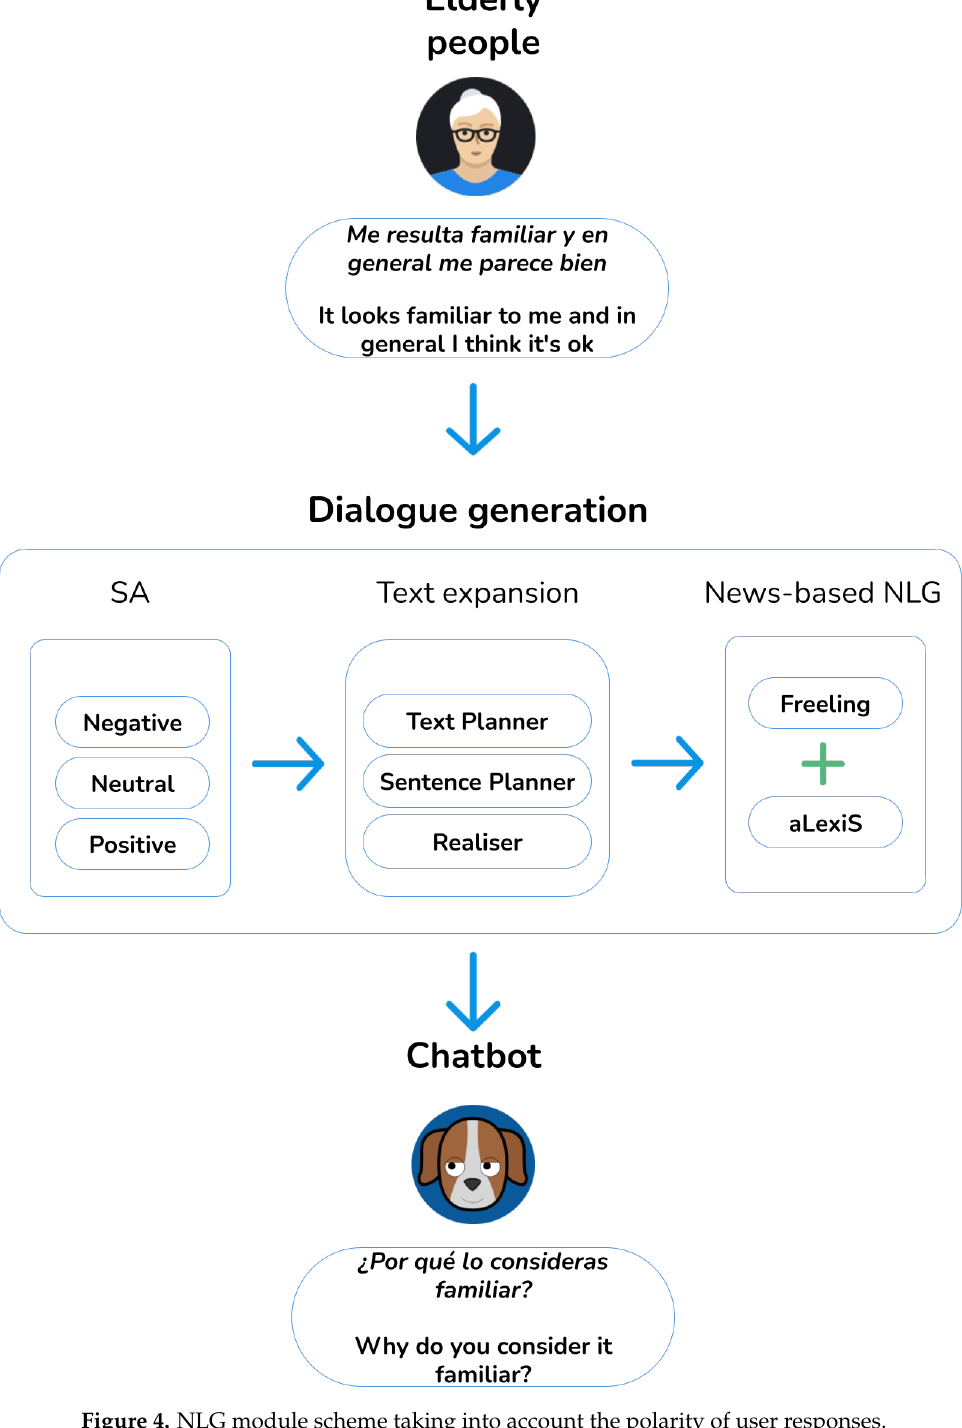
Figure 4. NLG module scheme taking into account the polarity of user